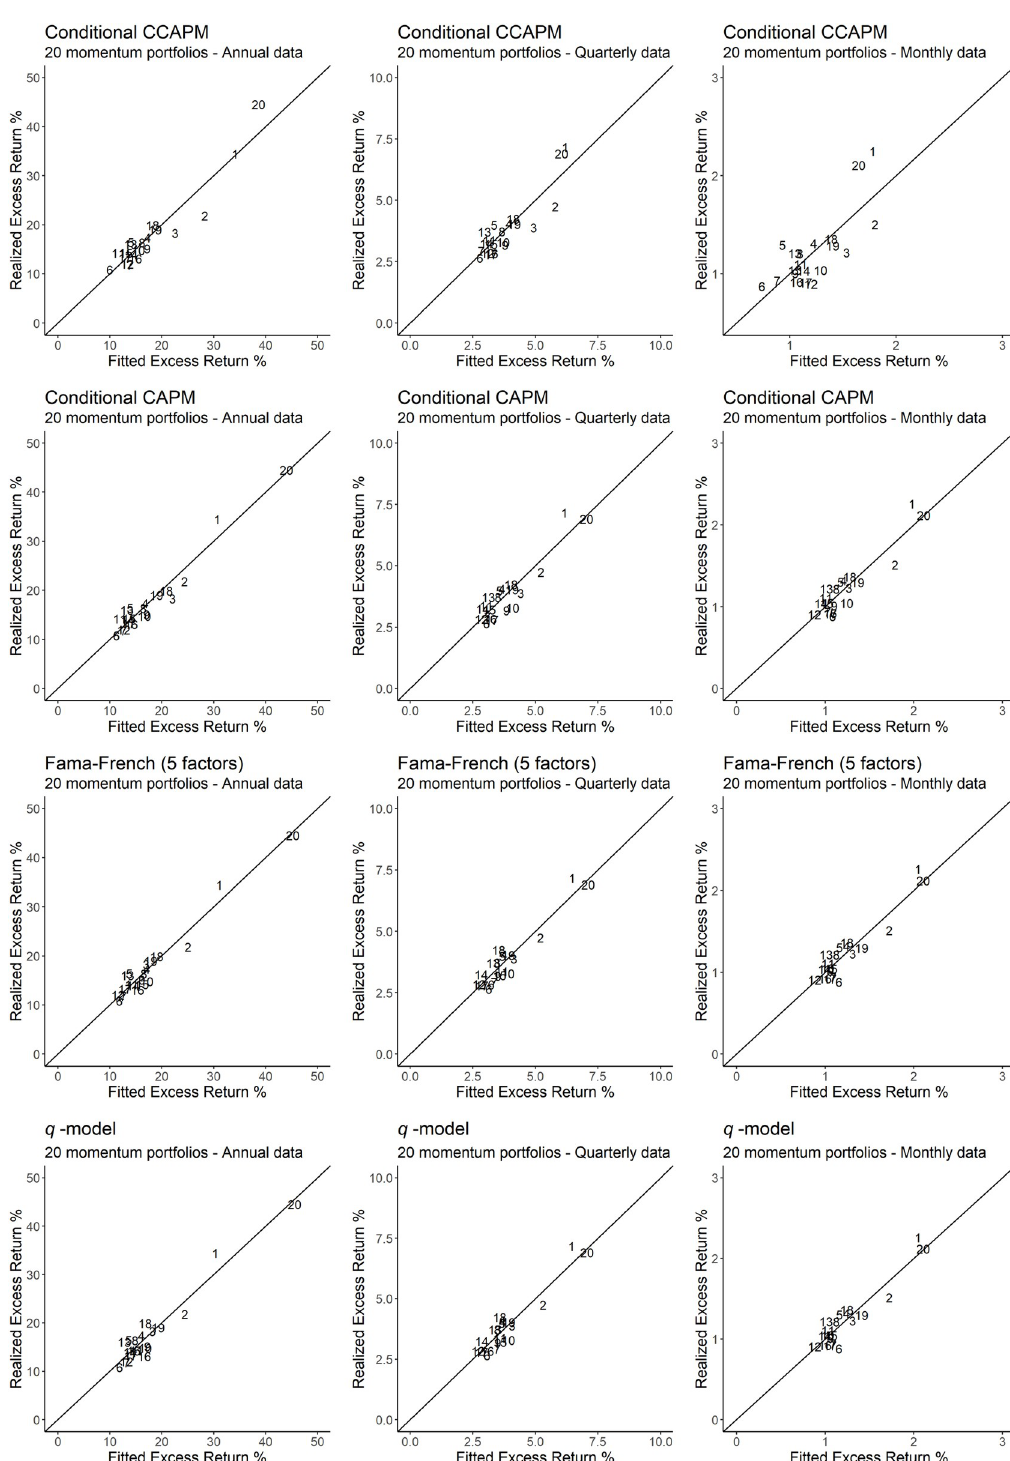
Fig 2. Realized excess returns versus fitted values for 20 momentum portfolios. The figure depicts 20 momentum portfolios using a number from 1 to 20. Stocks with the lowest past one-year return comprise portfolio 1 and stocks with the highest past one-year return comprise portfolio 20. The closer the portfolios are to the 45 degrees axis, the better the fit produced by the model.